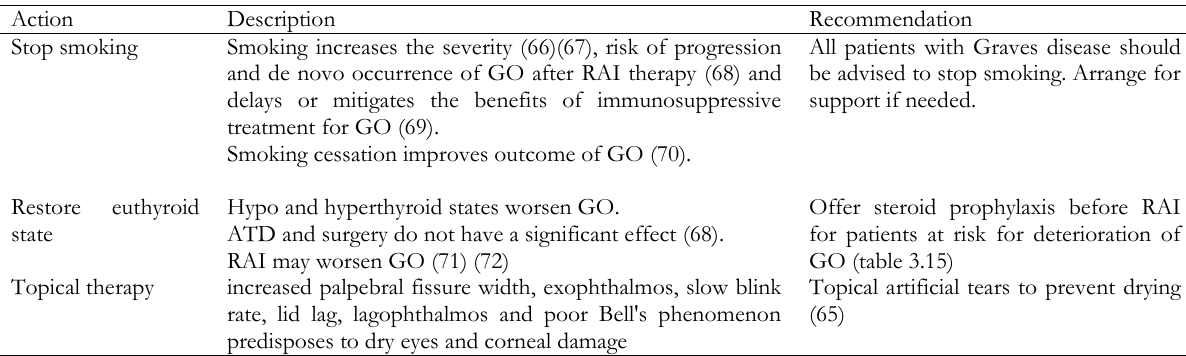
Table 3.14. General measures in the management of